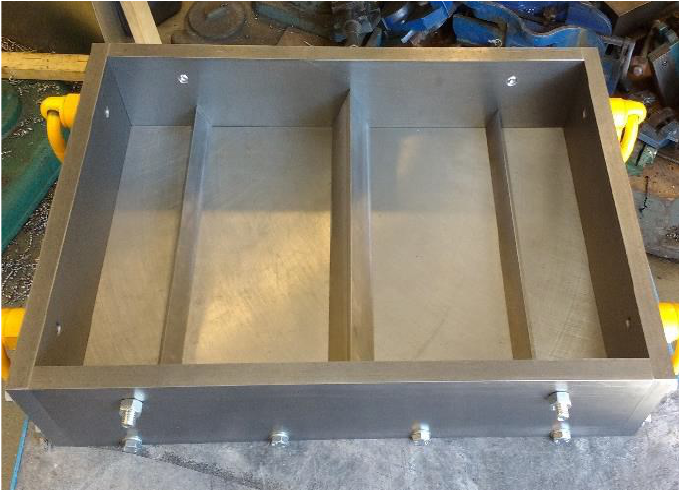
Figure 10. The complete mould.